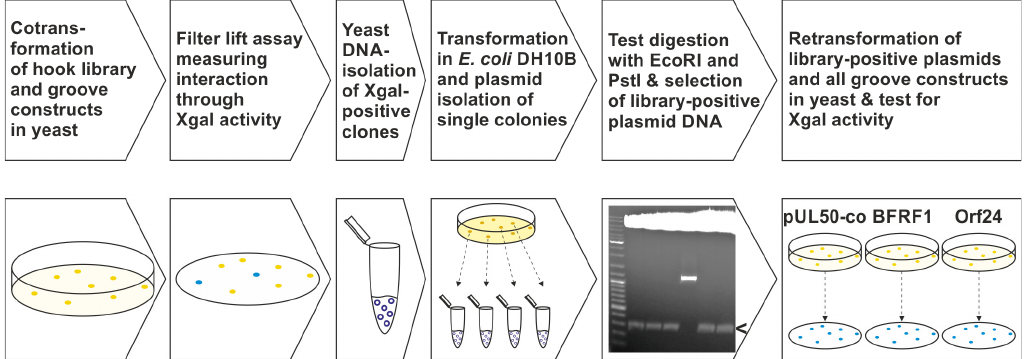
Figure 2. The methodological approach of the Y2H screening and further validation using